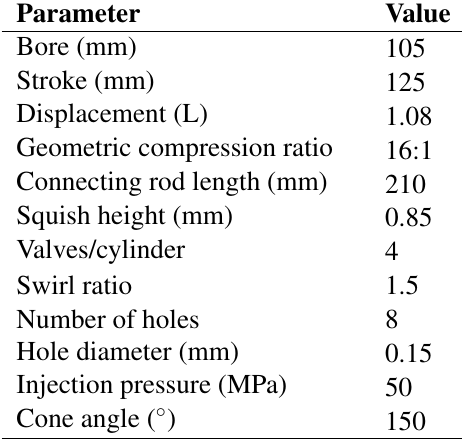
Table 1 Engine and injector specifications